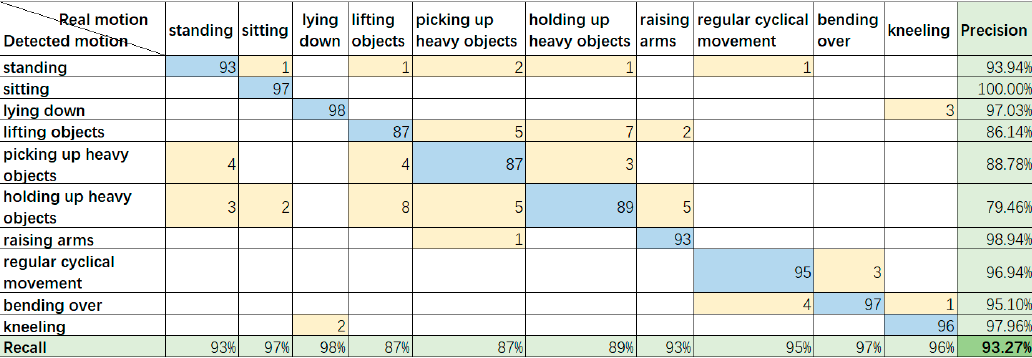
Figure 8. Simulation result for situation 1.